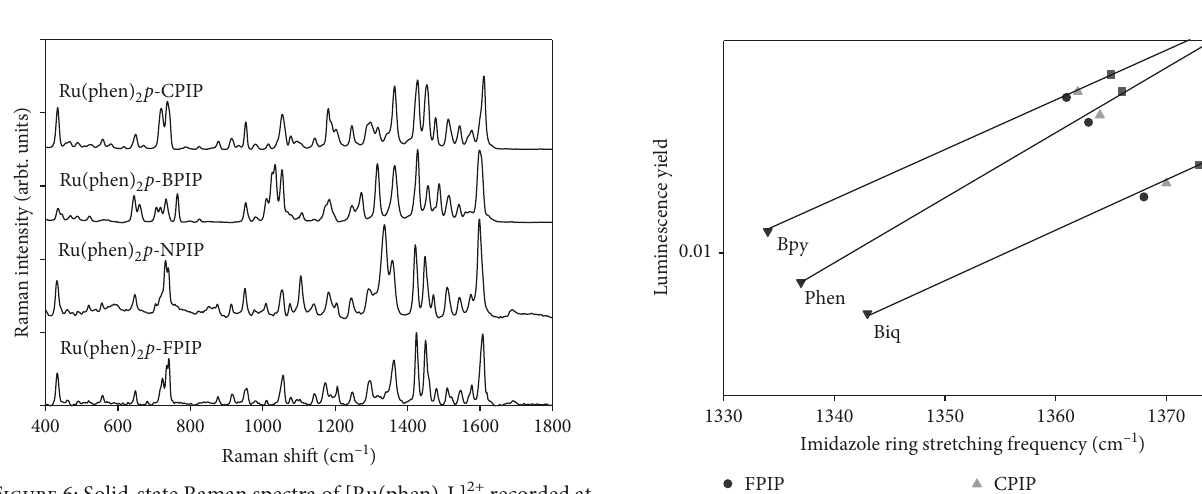
Figure 5: Graphical representation of the “donor-acceptor” description of electron density with end-group variation, showing Br to NO phen (a) and biq (b). Blue arrows indicate the electron delocalisation, and red arrows indicate the ability of the functional group to push back against the